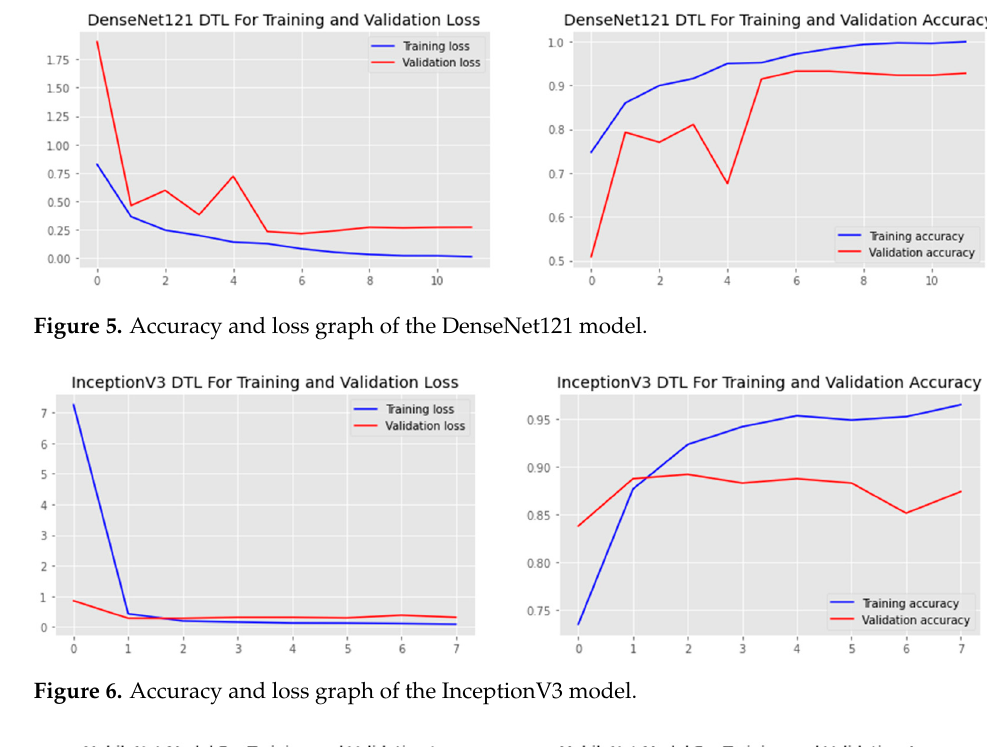
Figure 4. Accuracy and loss graph of the MobileNet-SVM model .